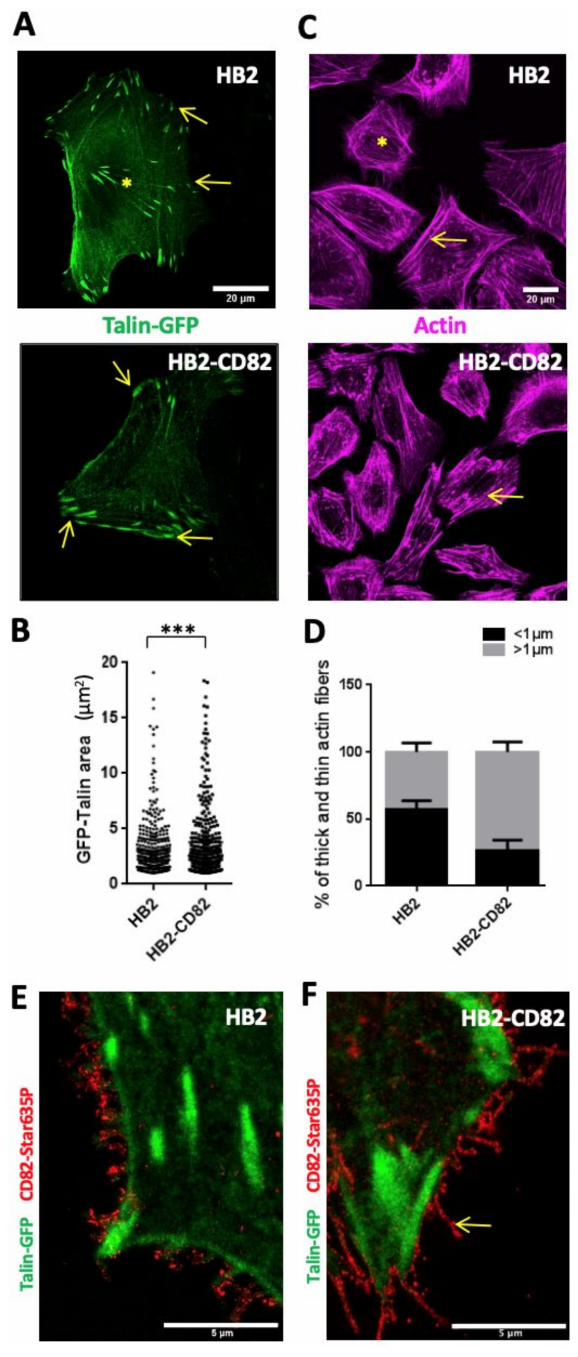
Figure 2. CD82 regulates both size and dynamics of focal adhesion and actin fiber sizes. ( A ) Talin-GFP labelling in HB2 and HB2-CD82 (left panel). Arrows indicate peripheral adhesions that are smaller in HB2 cells than in HB2-CD82 cells. The